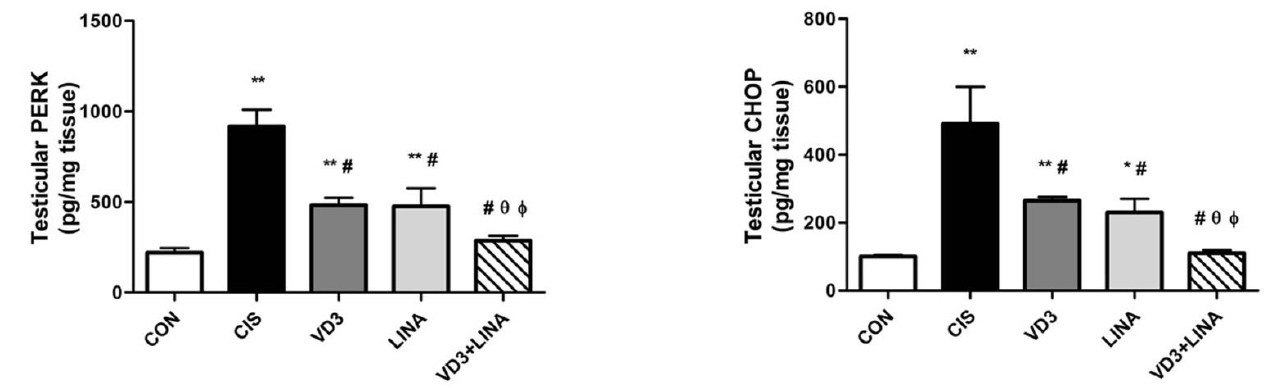
Figure 4. Effect of vitamin D3 and/or linagliptin on levels of ER stress-related proteins in testicular tissue of cisplatin-exposed rats. Bars with error bars represent means ± SEM, ( n = 6); * p < 0.01, ** p < 0.001 vs. CON group; # p < 0.001 vs. CIS group; θ p < 0.01 vs. VD3 group; φ p < 0.01 vs. LINA group. PERK: protein kinase RNA-like ER kinase; CHOP: transcription factor C/EBP homologous protein; CON group: control rats; CIS group: cisplatin-treated rats receiving drug vehicle; LINA group: cisplatin-treated rats receiving linagliptin therapy for 4 weeks; VD3 group: cisplatin-treated rats receiving vitamin D3 therapy for 4 weeks; VD3+LINA group: cisplatin-treated rats receiving combined therapy of linagliptin and vitamin D3 for 4 weeks.